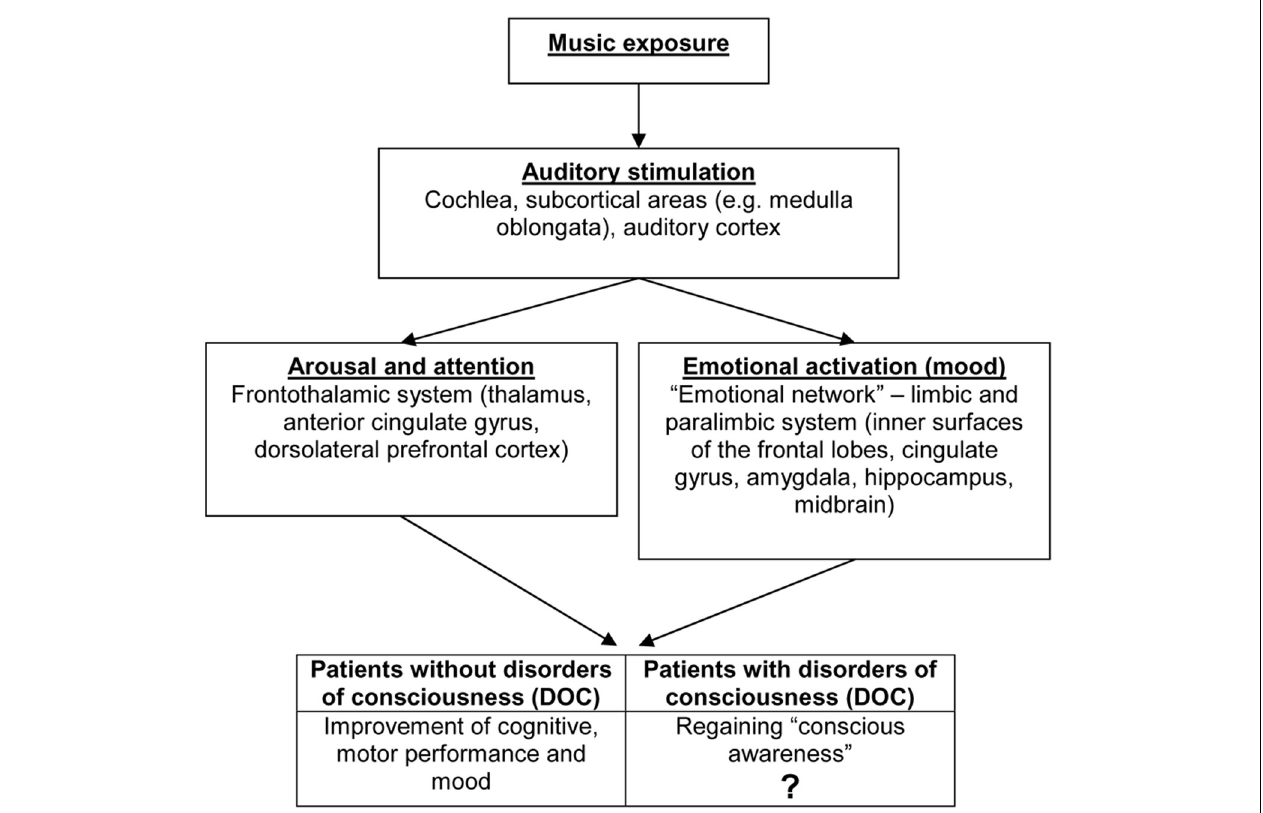
FIGURE 1 | Music processing. Potential effects of music listening and brain structures involved (Altenmüller and Schlaug, 2013). Strongly simplified model based on the “mood and arousal hypothesis” (Husain et al.,